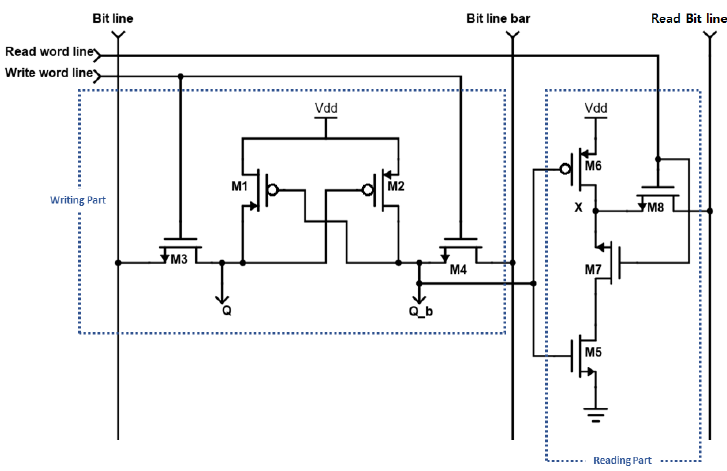
Figure 12. Proposed PLNA 8T SRAM